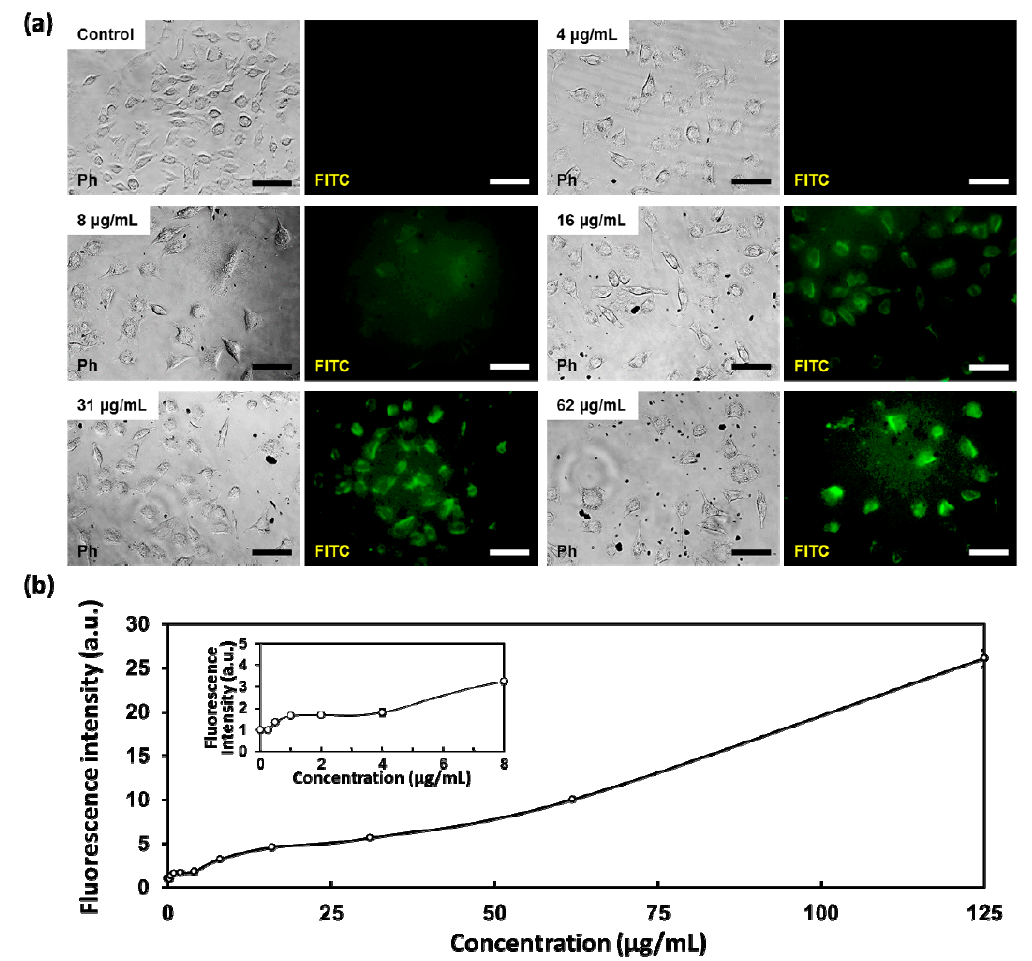
Figure 3. ( a ) Representative fluorescence microscopy images of oxidized DCF fluorescence in L-929 fibroblasts treated with various concentrations of layered BP (0, 4, 8, 16, 31 and 62 µ g/mL) for 24 h, and ( b ) quantification of oxidized DCF fluorescence intensity. The scale bars are 100 μ m.